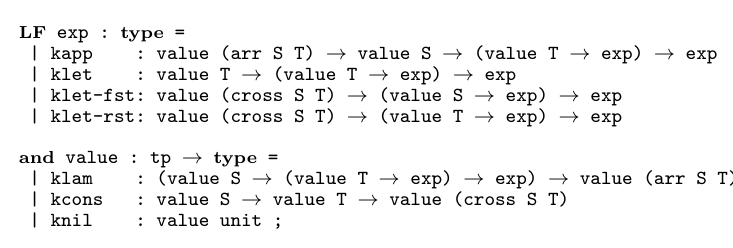
Fig. 6. Encoding of the Target Language of CPS in